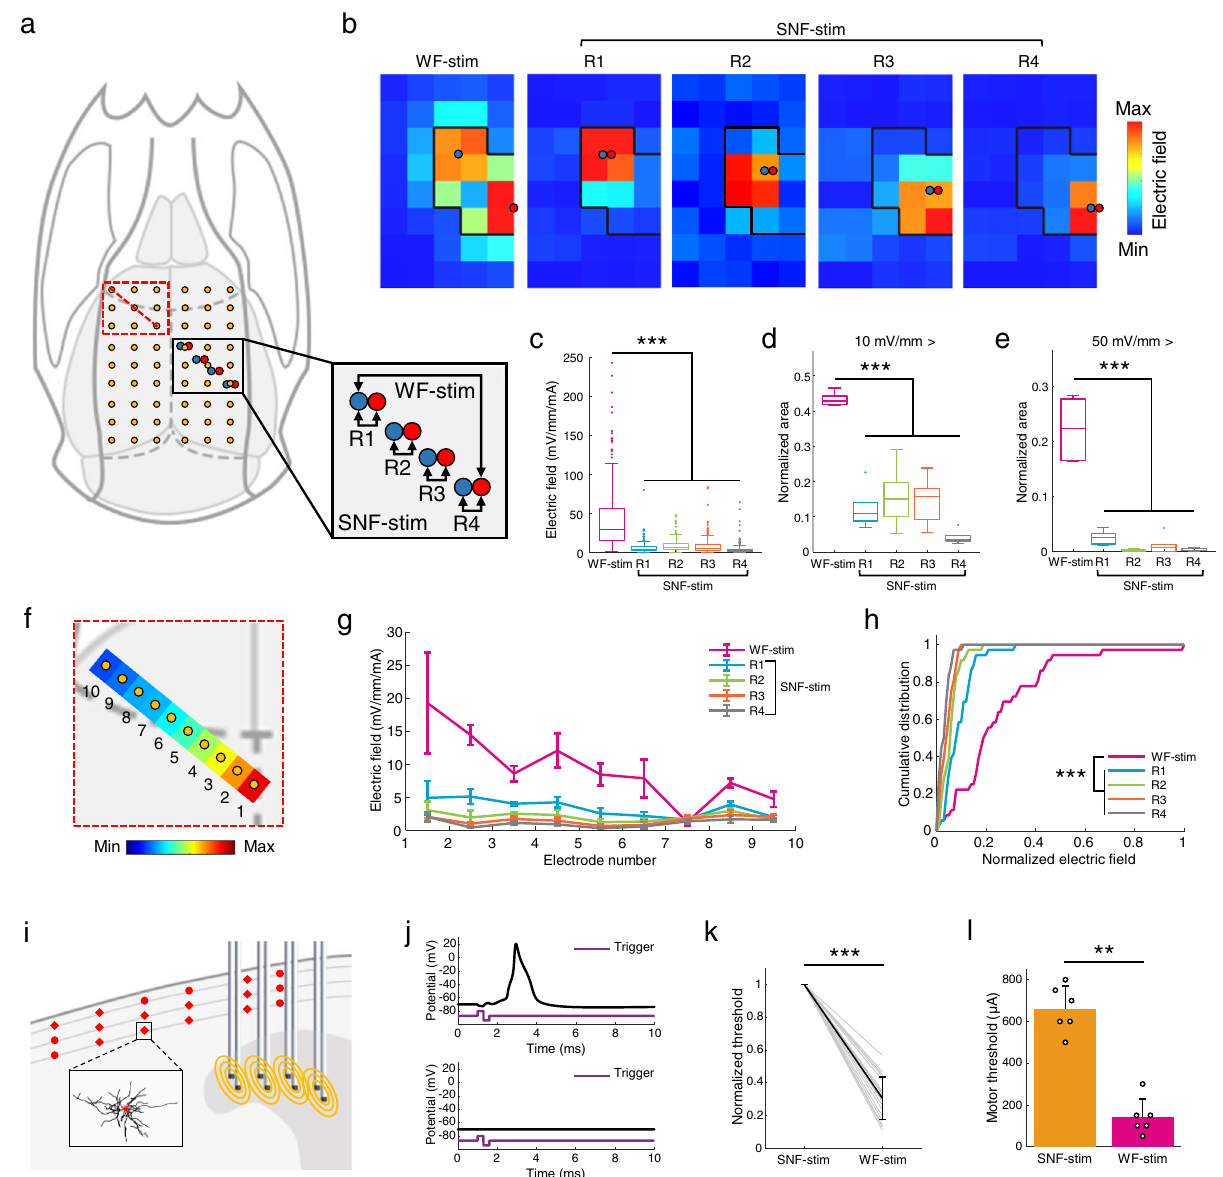
n =36normalized fi eldsinfourrats,Kolmogorov – Smirnovtest). i Simulationsetup for estimating the neural activation in cortical regions during hippocampal sti- mulation. j Examples of stimulus-induced action potential (top) and no response (bottom). k Computed thresholds for fi ring action potentials for each position ( P <0.001, n =18 samples per group, two-tailed paired t -test). The full data set is superimposed in gray. The thresholds were normalized to the result of the SNF stimulation for each case. l In vivo measurements of stimulus-evoked abnormal motor response ( P =0.0048, n =6 rats per group, two-tailed Mann – Whitney U - test). ** P <0.01; *** P <0.001. For each box plot, center bar indicates median, box indicates25th and 75th percentiles, and whiskersextend to the most extreme data pointswithoutoutliers(±1.5IQR).Outliersareshownindotsigns.Bargraphsdepict dataasmean±SD.WF-stimwide- fi eldstimulation,SNF-stimsequentialnarrow- fi